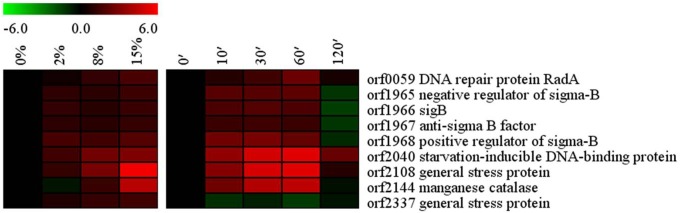
Alterations in SigB and SigB regulon related genes.Expression profiles are displayed on the basis of log2 ratios.